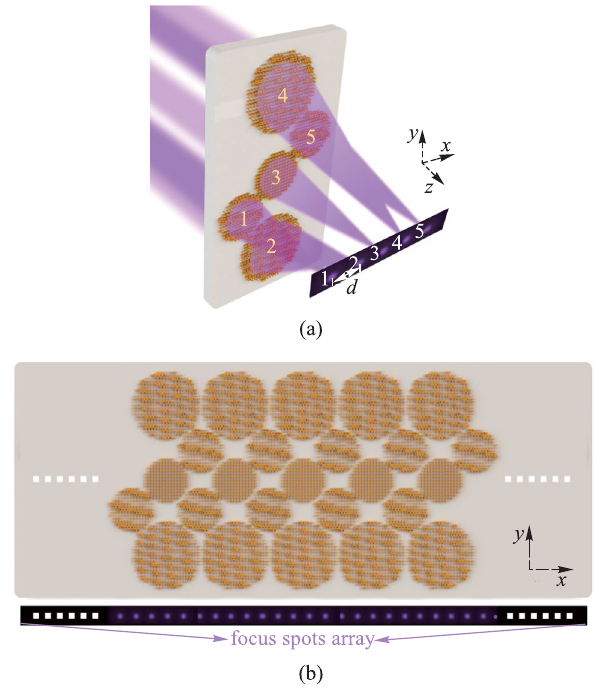
Fig. 1 Schematic of the device structure. a Diagram of a metalens molecule. b Diagram of SMA. The bottom figure shows the focused spot